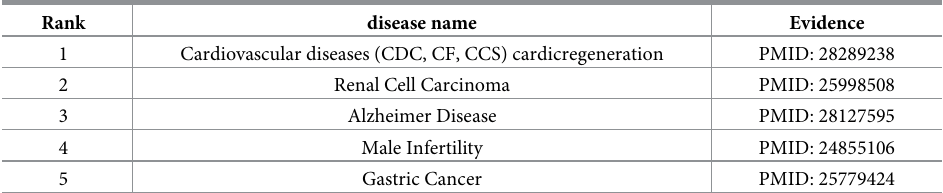
Table 6. The top five piR-hsa-23210 associated diseases and relevant